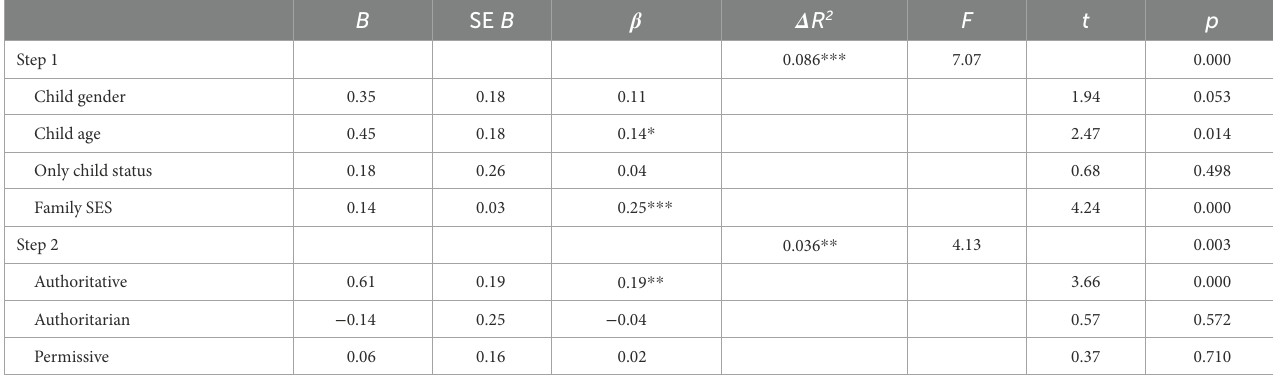
TABLE 2 Sequential multiple regression of pre-academic skills on parenting style.